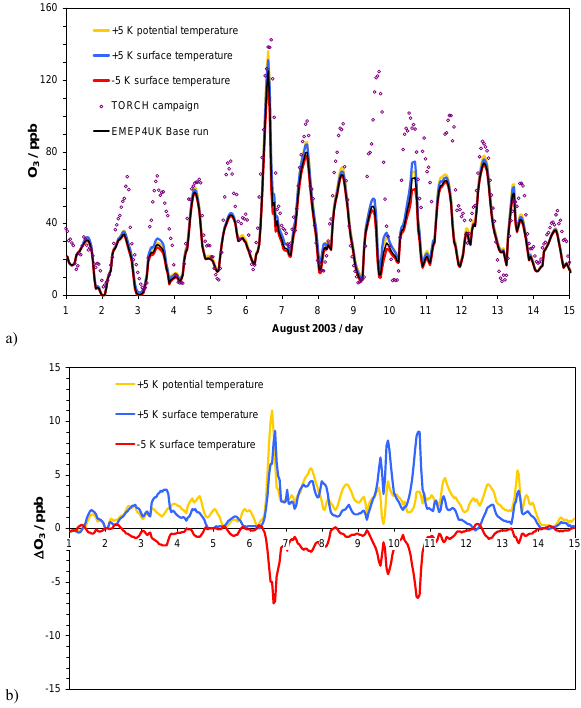
Figure 8: (a) Hourly time-series of modelled (lines) and measured (circles) surface ozone Fig. 8. (a) Hourly time-series of modelled (lines) and measured (cir- (ppb) for August 1st-15th 2003 at the TORCH campaign site, Writtle. EMEP4UK baseline cles) surface ozone (ppb) for 1–15 August 2003 at the TORCH cam- simulation (black line) and model sensitivity experiments for 3D potential temperature (+5 K paign site, Writtle. EMEP4UK baseline simulation (black line) and yellow) and surface temperature (+5 K, blue; -5 K red): (b) change in O 3 (ppb) for the three model sensitivity experiments for 3-D potential temperature (+5K sensitivity experiments relative to the baseline. yellow) and surface temperature (+5 K, blue; − 5K red): (b) change in O 3 (ppb) for the three sensitivity experiments relative to the base-